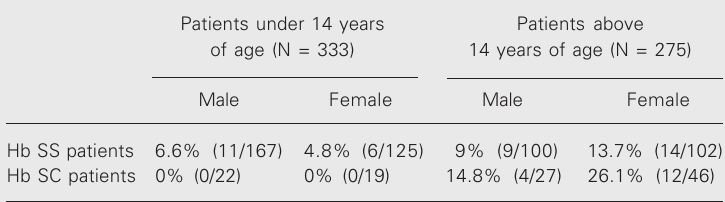
Table 4. Frequency of alloimmunization for patients younger or older than 14 years according to gender and type of sickle cell